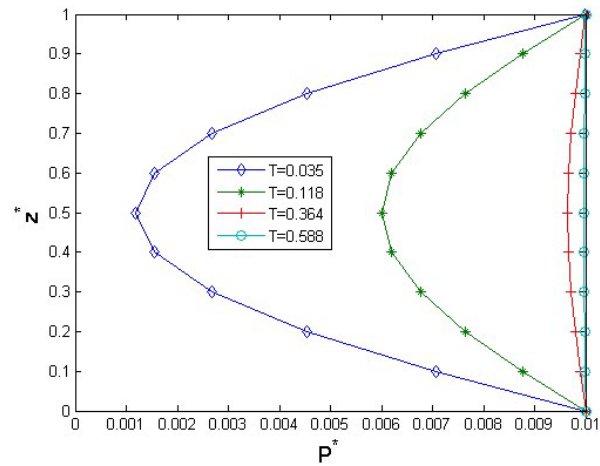
Figure 2. The dimensionless pore water pressure with respect to the dimensionless depth at different elapsed times.